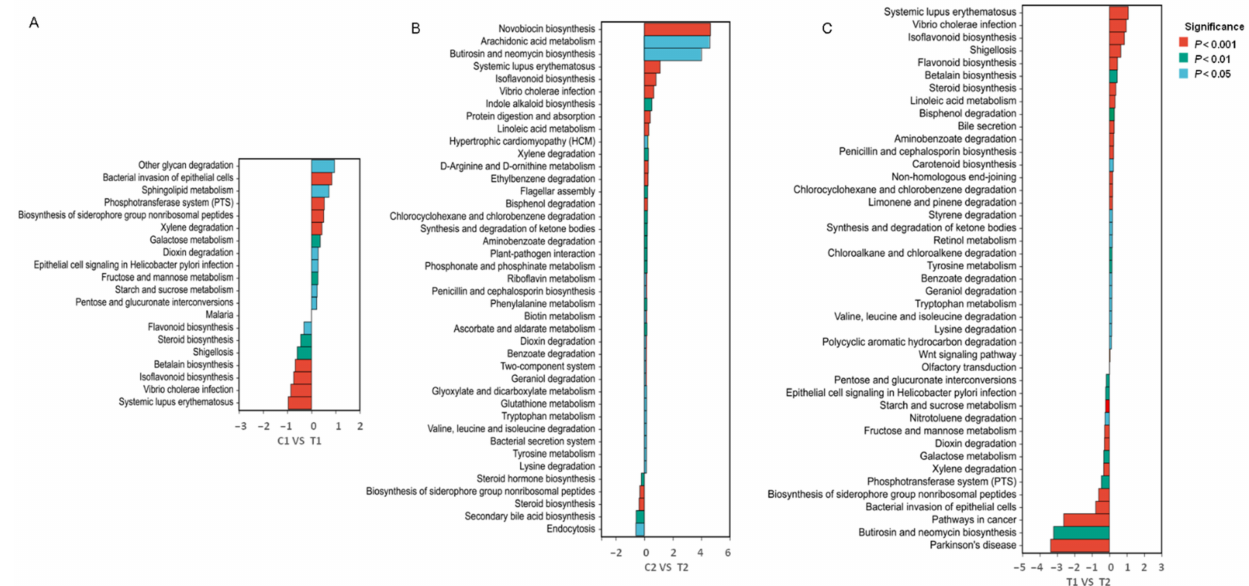
Figure 6. Metabolic functions of Cipangopaludina cathayensis intestinal microbiota in all samples pre- dicted on the basis of the Kyoto Encyclopedia of Genes and Genomes (KEGG) database. ( A )